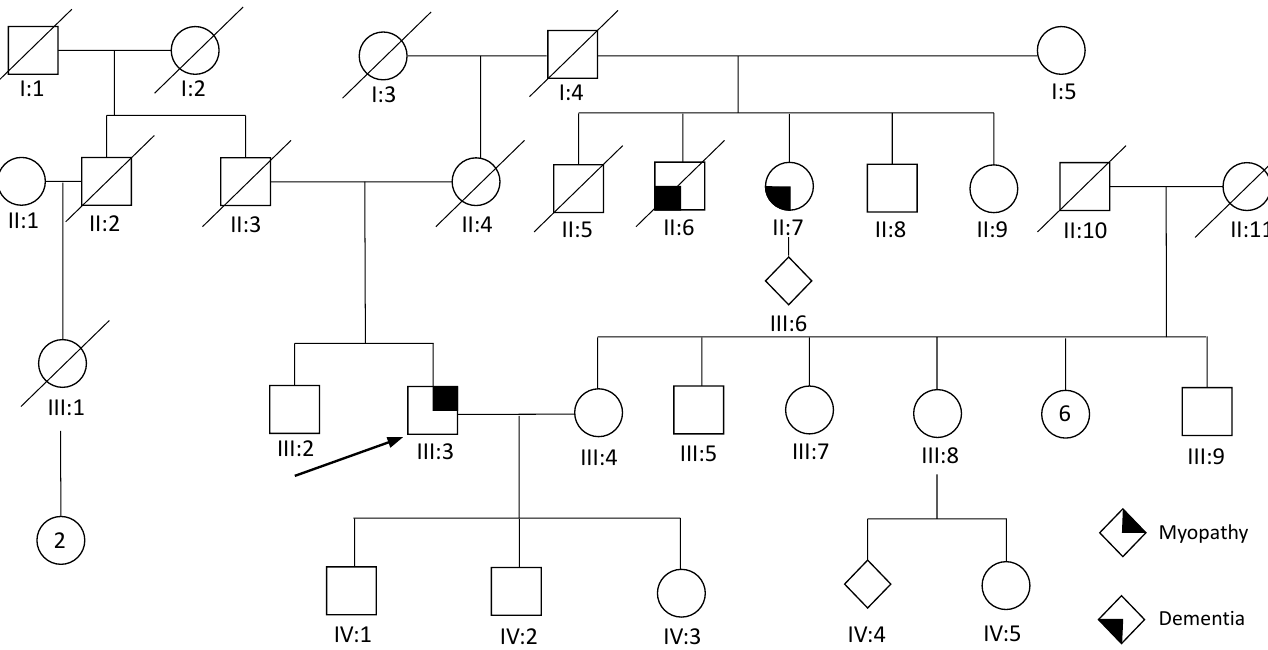
Figure 1. Pedigree of proband 1. Proband (III:3) is indicated by the arrow. Laboratory results revealed a CK of 117 IU/L, and the cytosolic 5 (cid:48) -nucleotidase 1A (NT5c1A) antibody testing was negative. The EMG revealed spontaneous activity in the form of fibrillation potentials, a mix of large and small amplitude motor units, reduced recruitment in the right tibialis anterior and medial gastrocnemius, and early recruitment in the right vastus lateralis. Muscle biopsy of the right thigh revealed muscle fiber size variability (Figure 2B), with patchy areas of marked atrophy. Degenerating and regener- ating fibers, foci of myophagocytosis, angulated fibers, and numerous internally placed nuclei were observed. There were rare vacuoles. No signs of mitochondrial dysfunction (e.g., ragged, red fibers) were seen. There was no evidence of endomysial inflammation. The MRI findings of bilateral thighs showed atrophy and fat replacement in the anterior and posterior compartments (Figure 2C). The proband’s medical history was significant for a small disc herniation at L4-5, suffered from heart disease in his mid-70s, whereas his mother (II:4) had unexplained distal lower extremity weakness at the age of 75 years. The maternal uncle (II:6) and aunt (II:7) both suffered from dementia in their 50s and mid-70s,